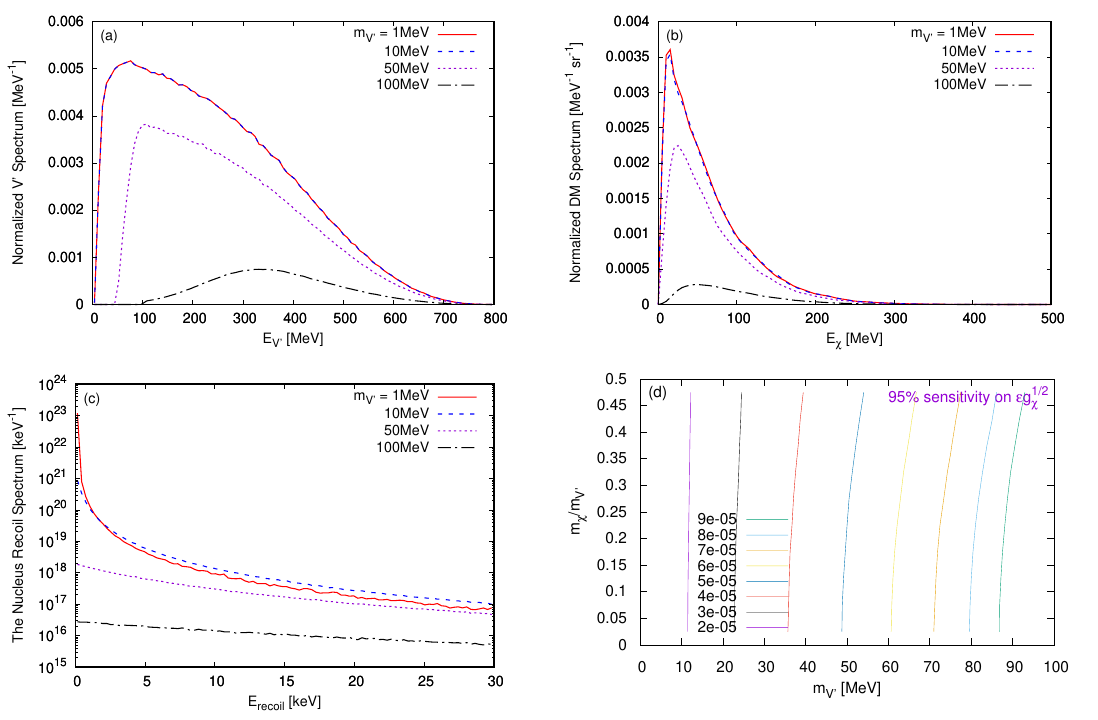
Figure 2 . The normalized (cid:13)uxes for (cid:31) (a) from (cid:25) 0 decay at the COHERENT experiment. On the detection side, (b) shows the recoil energy spectrum in 308 live-days of data collection with 14.6 kg of CsI[Na] while (c) and (d) shows the corresponding 95% sensitivity on the DM coupling (cid:15)g 1 = 2 (cid:31) .